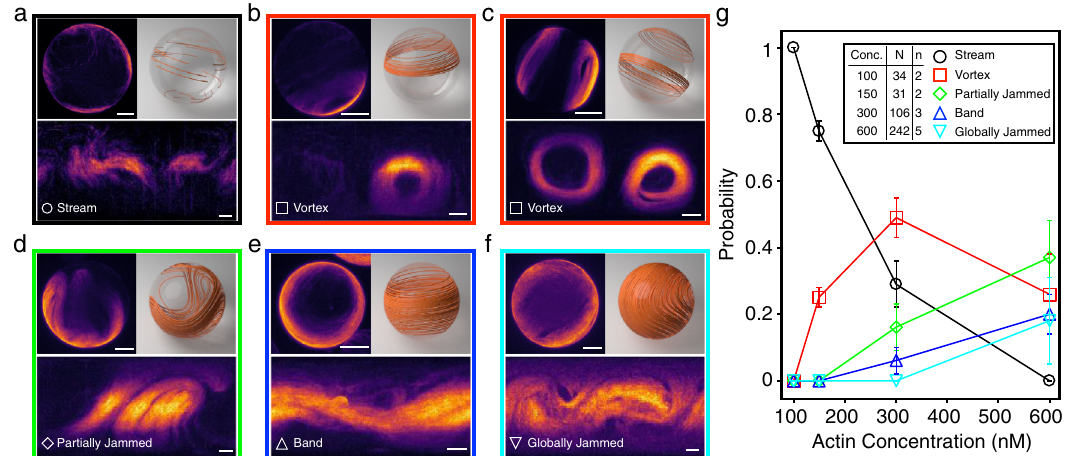
Fig. 2 Polar patterns on active actin vesicles. a – f Z-projections (top-left), 3D schematics (top-right), and equirectangular projections (bottom) of vesicle displaying different polar patterns: stream ( a ), vortex ( b ), vortices ( c ), partially jammed ( d ), band ( e ), and globally jammed ( f ). Scale bars, 10 μ m. g Distributions of each observed polar pattern at different encapsulated actin concentrations. Inset indicates the number n of repeated experiments and the total number N of vesicles counted at each concentration. Error bars represent the standard deviations from repeated experiments. Empty vesicles are excluded from the statistics. The graph shows a tendency towards more complex structures as the concentration increases and topological constraints become more